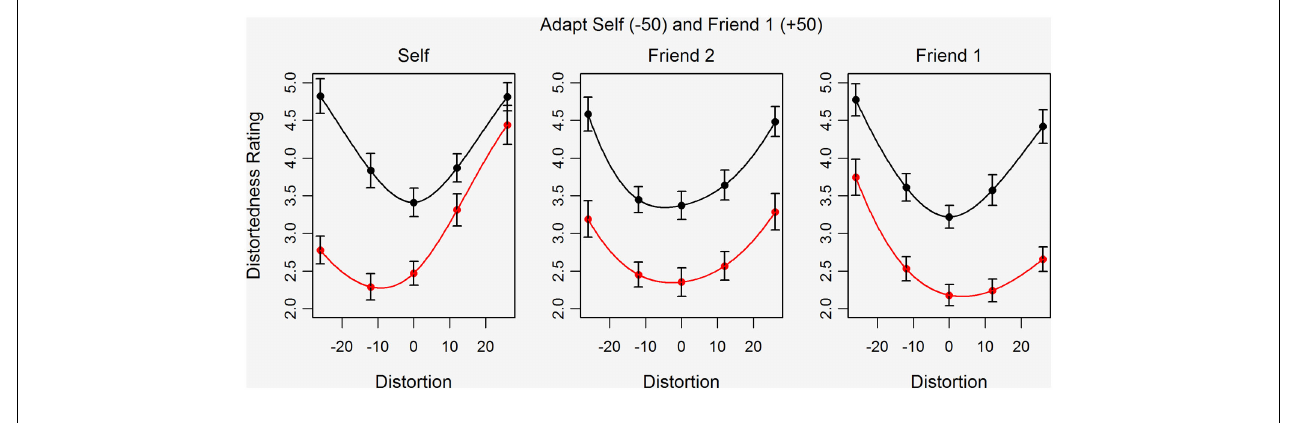
1 faces in Study 2. Error bars show ± standard error of the mean. Separate plots are shown for Self (left), Friend 1 (right), and Friend 2